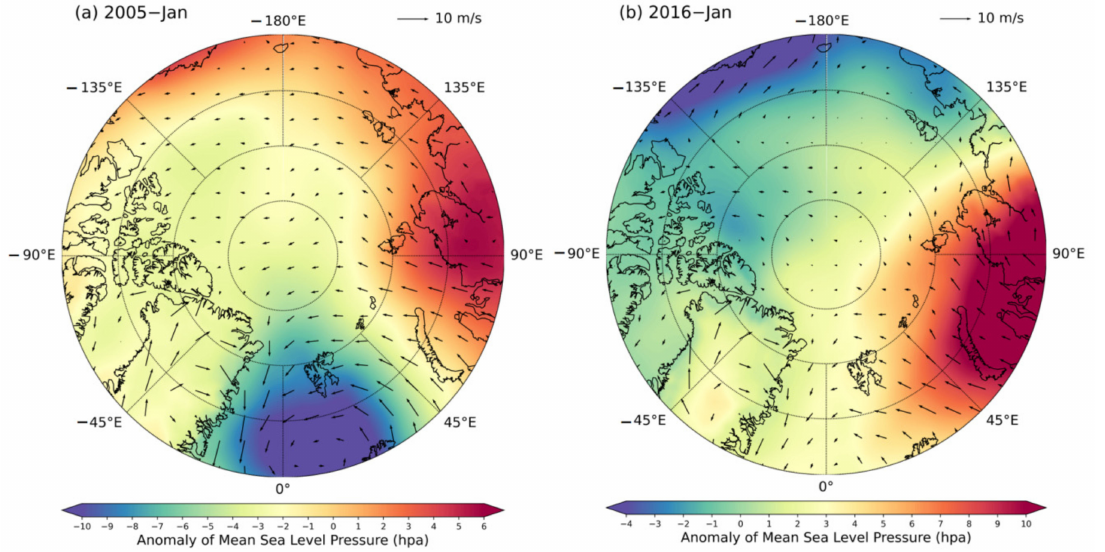
Figure 15. ERA5 SLP anomaly of ( a ) 2005 January and ( b ) 2016 January, with the same value of DA index (DA = −